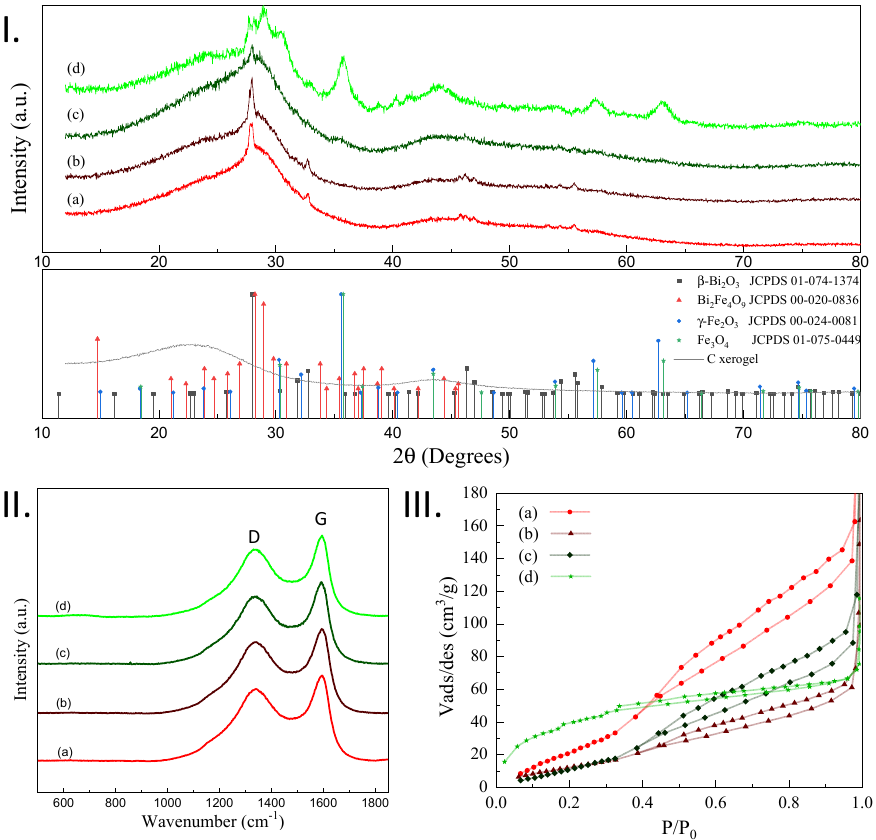
Figure 1. Characterization of (a) CXBiFe 0 , (b) CXBiFe 0.01 , (c) CXBiFe 0.12 and (d) CXBiFe 1.2 investigated samples through ( I ). XRD with attached reference signals specific to bare carbon xerogel, β -Bi 2 O 3 , mullite Bi 2 Fe 4 O 9 , maghemite Fe 2 O 3 , and Fe 3 O 4 magnetite ( II ). Raman spectroscopy revealing the D and G carbon specific vibrational region, and ( III ). N 2 adsorption/desorption isotherms.